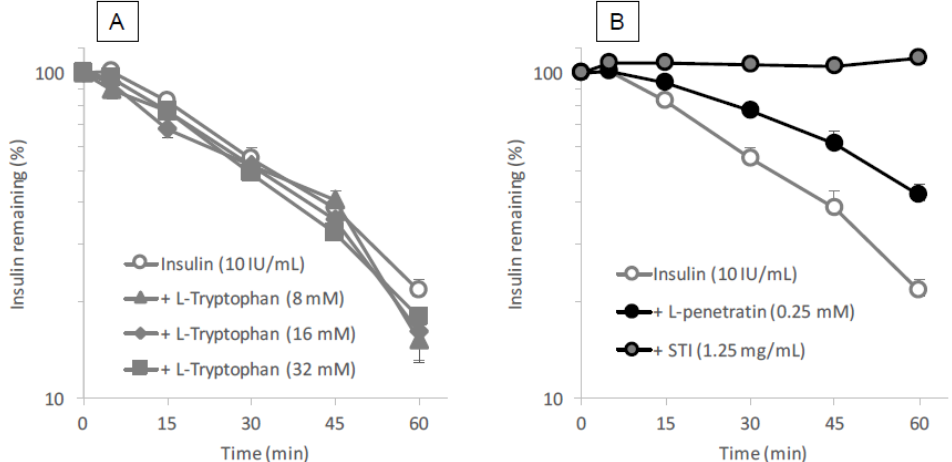
Figure 8. Degradation profiles of insulin in the presence of tryptophan or positive controls (penetratin and STI) in rat intestinal enzymatic fluid. Panel ( A ), various concentrations of L -tryptophan (8–32 mM); panel ( B ), L -penetratin (0.25 mM) or STI (positive control, 1.25 mg/mL). Each data point represents the mean ± SEM of N = 3.